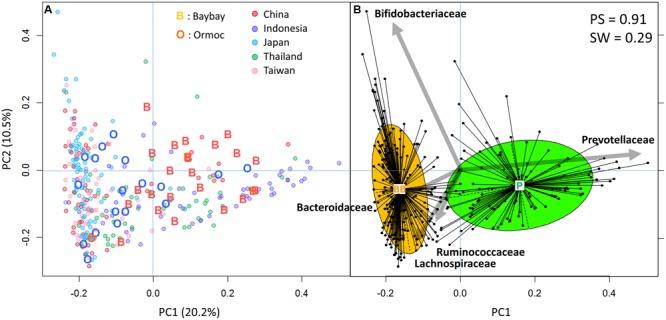
Principal component analysis (PCA) and clustering of gut bacterial community of 43 Leyte children and 295 Asian Microbiome Project (AMP) Phase I children. (A) PCA plot of 338 children samples. Family level bacterial composition of 338 samples was subjected to PCA and the first two principal components, PC1 and PC2, were plotted. “O,” Ormoc children; “B,” Baybay children; colored circles, countries of the AMP Phase I study. Percentage values in parentheses next to PC1 and PC2 represents percentage of variance explained by each component. (B) Clustering of the 338 samples. The family level composition data were subjected to Jensen–Shannon divergence and partitioning around medoids cluster analysis. To maximize the Calinski–Harabasz index, an optimal number of clusters was chosen; the result was then validated based on prediction strength (PS) and average silhouette width (SW). The clustering result is displayed using the PCA plot. The center of gravity of each cluster is indicated by a rectangle with the name of a type of microbiota. The colored ellipse covers 67% of the samples belonging to a cluster. The five largest PCA loadings of bacterial families are indicated by arrows next to their family names.